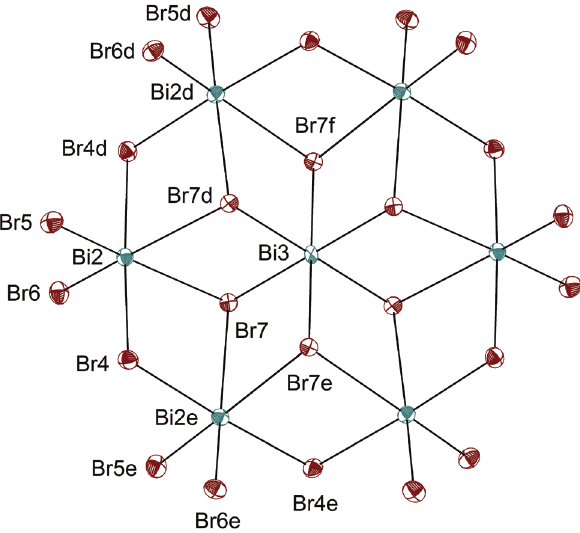
Figure 2 Thermal ellipsoid plot of the structure of the anionic part of 1 , [Bi Br ] 3- ( 1b 7 24